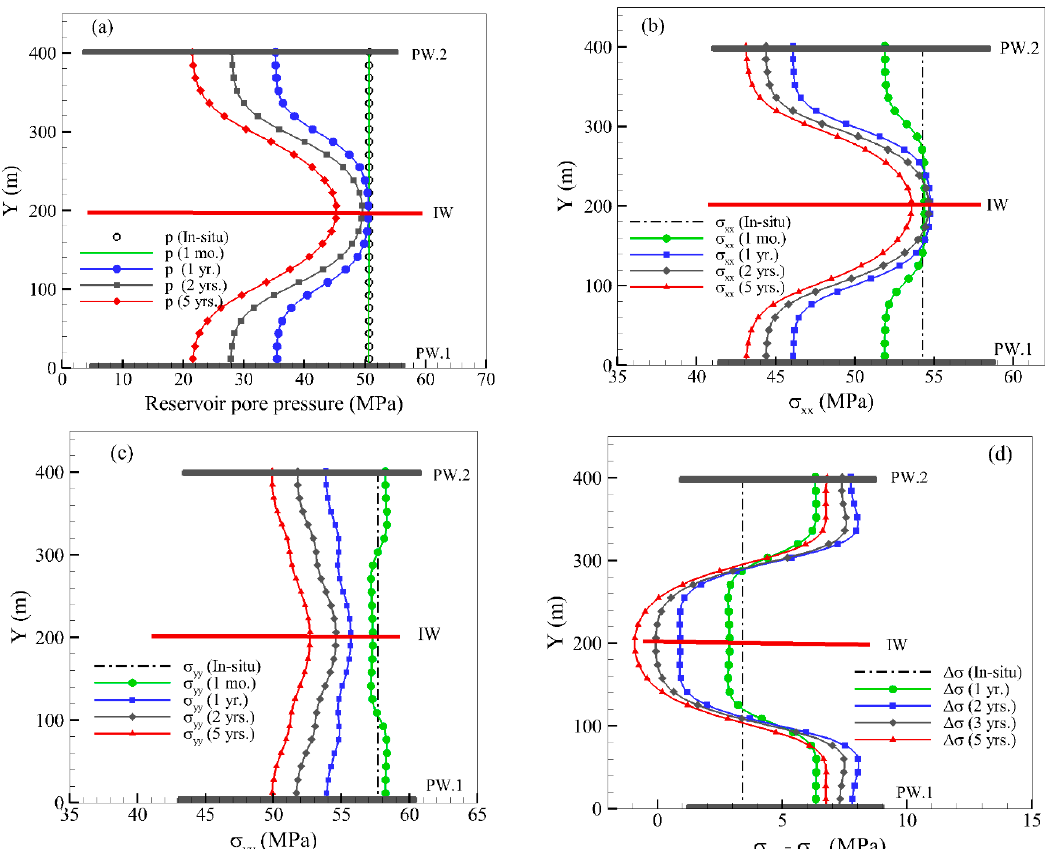
Figure 19. Temporal variation of ( a ) reservoir pore pressure, ( b ) horizontal stress component σ xx , ( c ) horizontal stress component σ yy , and ( d ) horizontal stress anisotropy ( σ yy − σ xx ) along the potential propagation path of the infill well fractures (along dotted “blue line” in Figure 11b) in the central XY-plane. Negative values of the horizontal stress contrast (part d) show stress reversal zones.